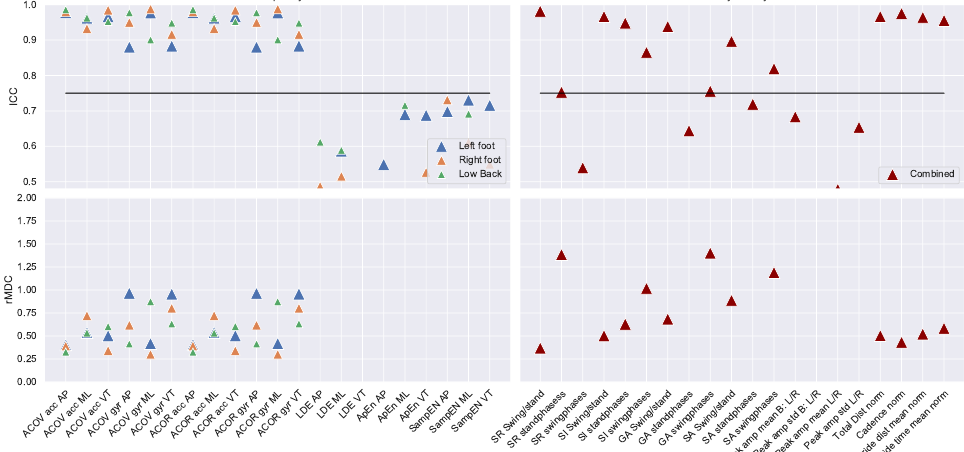
Figure 4. The ICC values (top panels) and rMDC values (bottom panels) of the complexity and asymmetry features for the left foot (blue triangle), the right foot (orange triangle), the low back (green triangle), and combined (red triangle). All outcomes above the horizontal black line were measured with good–excellent reliability. The exact outcomes of all gait features are provided in Table A1 in the Appendix